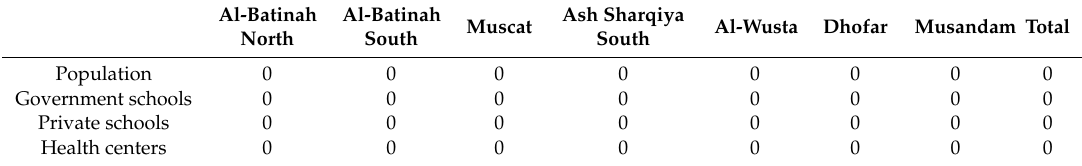
Table 4. The vulnerability matrix of the 2 m run-up tsunami scenario at the governorate level.